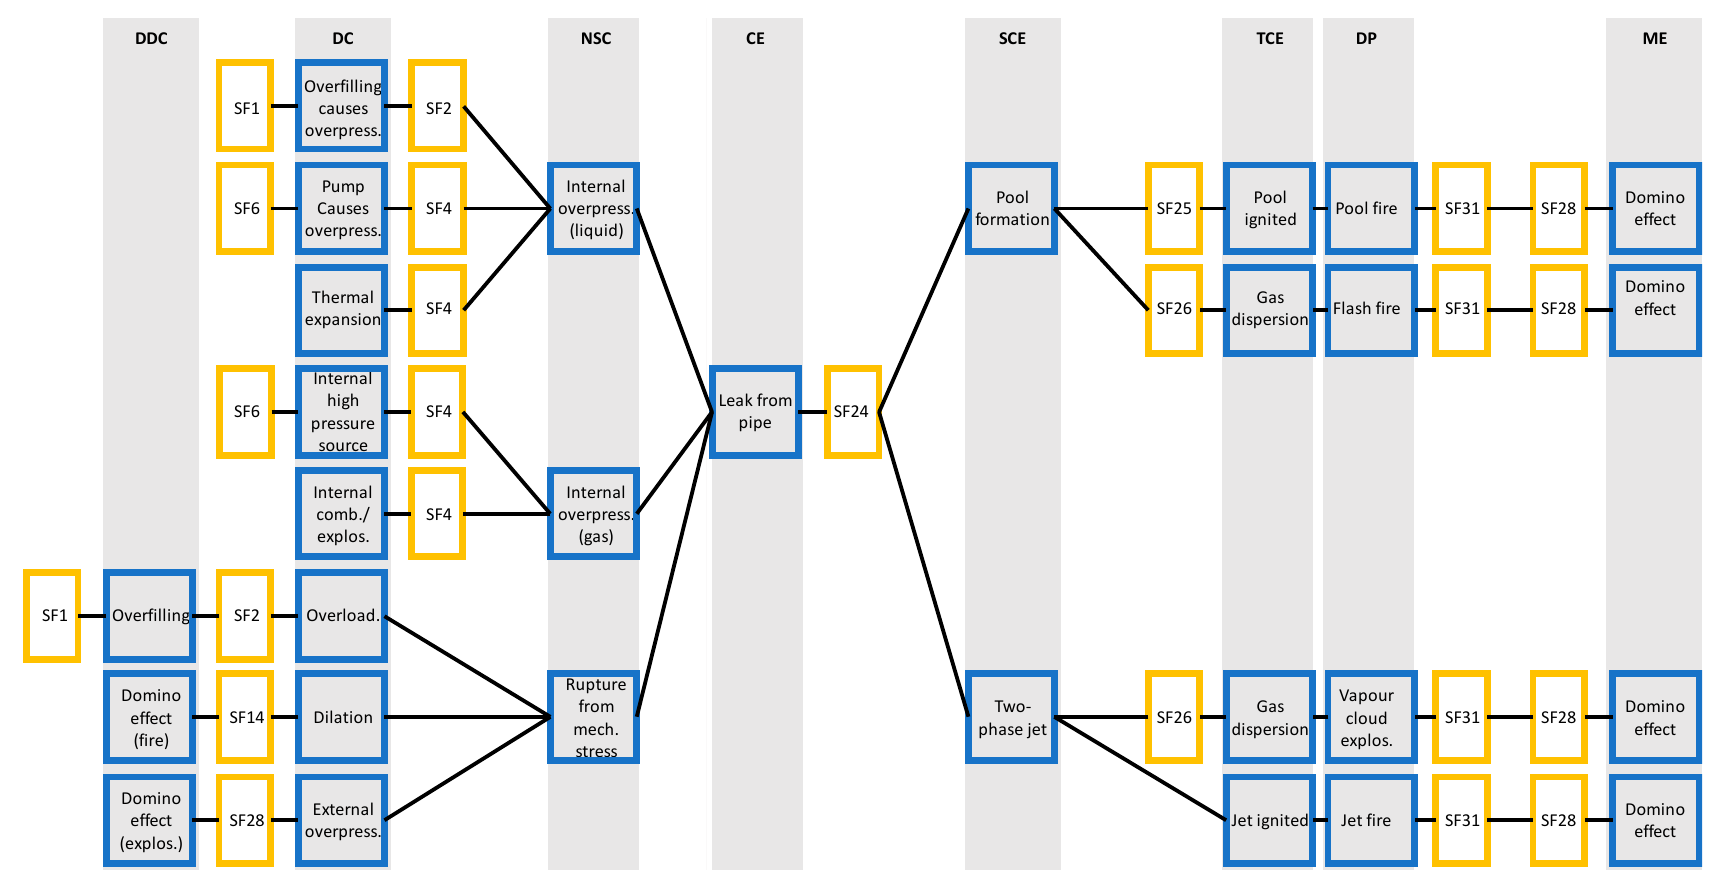
Figure 6. Bow-tie diagram for the LOC of crude oil from the pipe network. Blue boxes represent unwanted events. Yellow boxes represent safety functions. DDC = detailed direct cause; DC = direct cause; NSC = necessary and sufficient condition; CE = critical event; SCE = secondary critical event; TCE = tertiary critical event; DP = dangerous phenomenon; ME = major event.